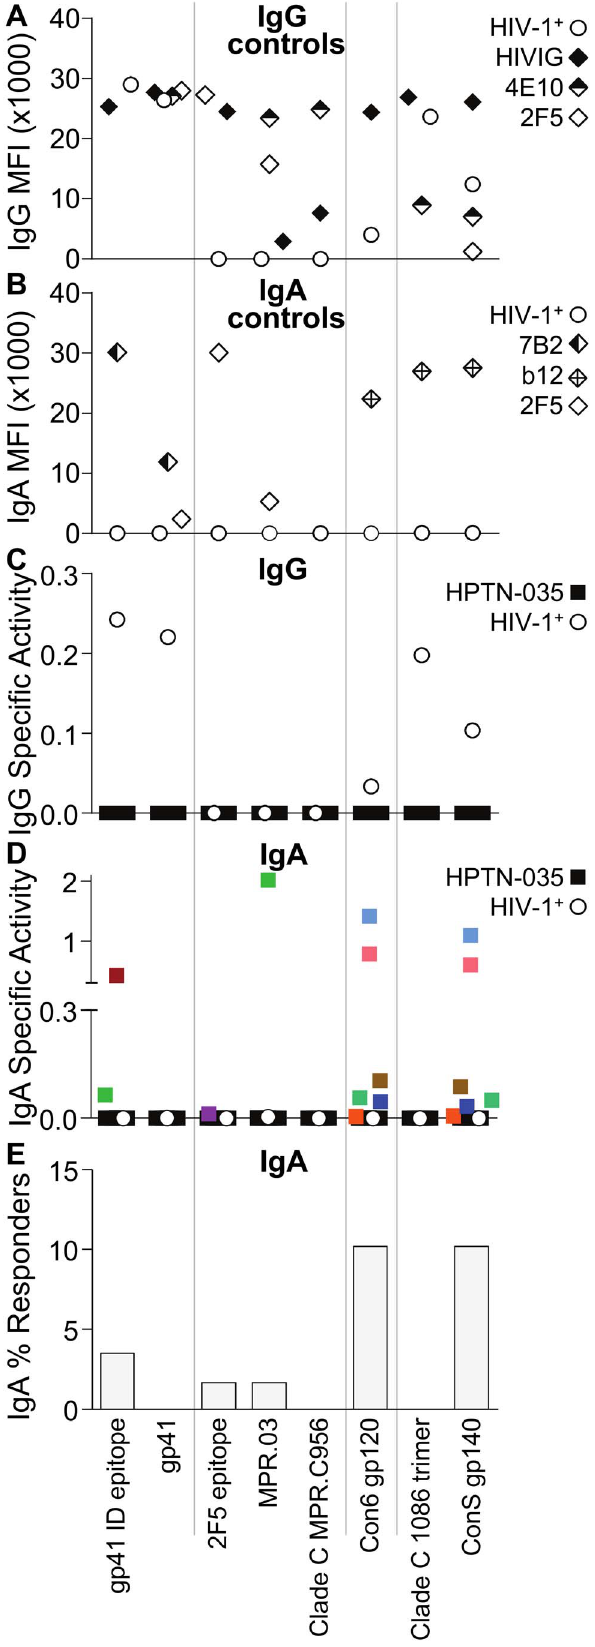
Figure 3. HIV-1 exposure elicits anti-Env IgA but not IgG antibodies in the vaginal mucosa. Vaginal Dacron swabs were collected from 57 HIV seronegative women enrolled in the HPTN 035 microbicide trial and analyzed for IgG (C) and IgA (D–E) binding to the indicated HIV-1 Env antigens. (A) Positive IgG controls. Binding of purified pooled HIV-1 + immunoglobulin (HIVIG), 4E10 monoclonal IgG (50 m g/ml), 2F5 monoclonal IgG (16 m g/ml) and swabs from an HIV-1 infected HPTN 035 participant (HIV + ) in mean fluorescent intensity (MFI). (B) Positive IgA controls. Binding of 7B2 monoclonal IgA (1 m g/ml), b12 monoclonal IgA (20 m g/ml) and 2F5 monoclonal IgA (1 m g/ml) in MFI. Lack of IgA binding from an HIV-1 infected HPTN 035 participant (HIV + ) is also shown. (C) HIV-1 antigen-specific IgG activity, calculated as antigen-specific MFI/ng ml 2 1 total IgG, in 57 women participating in HPTN 035. One additional HIV-1 infected HPTN 035 participant (HIV + ) is also shown. (D) HIV-1 antigen-specific IgA activity, calculated as antigen-specific MFI/ng ml 1 total IgA. For the 57 HPTN 035 women (squares), black symbols signify negative responses and colored symbols signify positive responses, with colors indicating specific women. Samples that did not meet the positivity criteria are displayed at zero for specific activity. One additional HIV-1 infected HPTN 035 participant (HIV + ) is also shown (open circles). (E) Percentage of the 57 HPTN 035 women with positive IgA